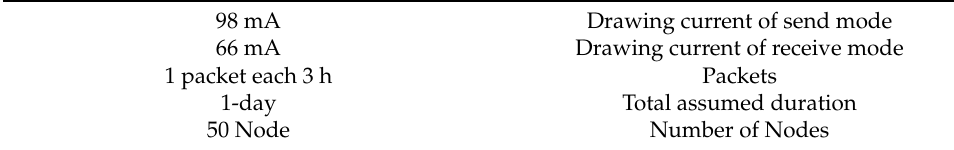
Table 5. Energy consumption